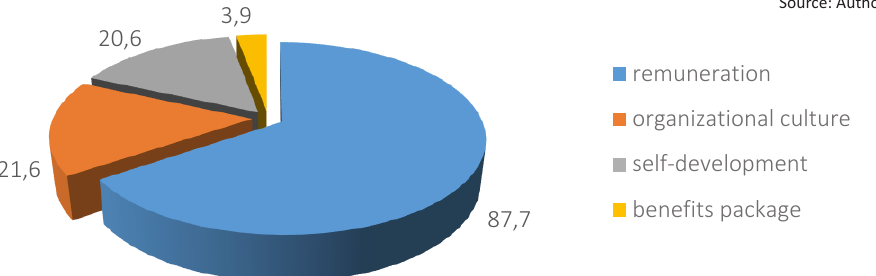
Figure 5. Factors important for medical staff members while choosing a workplace in